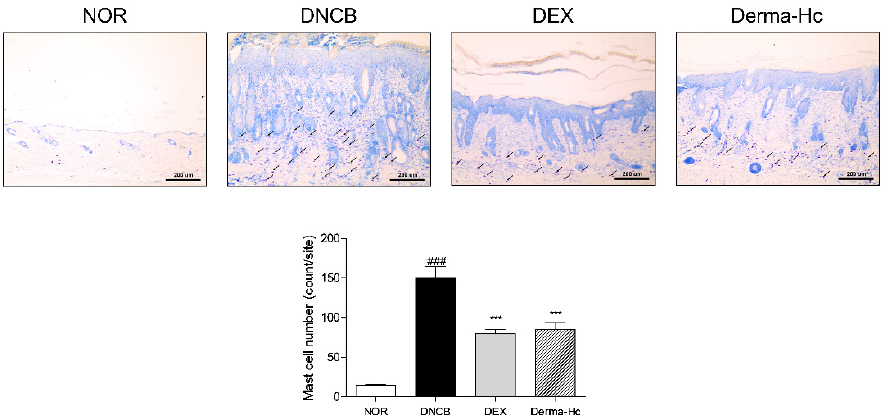
Figure 4. Derma-Hc reduces infiltration of mast cells in DNCB-induced mice. NOR, Normal saline- treated group; DNCB, 2,4-dinitrochlorobenzene (DNCB)-sensitized group; DEX, DNCB-sensitized and dexamethasone-treated group. Mast cells in dermis were stained with toluidine blue indicated as black arrow and presented as purple. Scale bar is 200 μ m. The number of mast cells in five sites randomly designated were counted by Image J program. The data are presented as mean ± standard error of the mean. ### p < 0.001 compared to NOR group. *** p < 0.001 compared to individual groups.